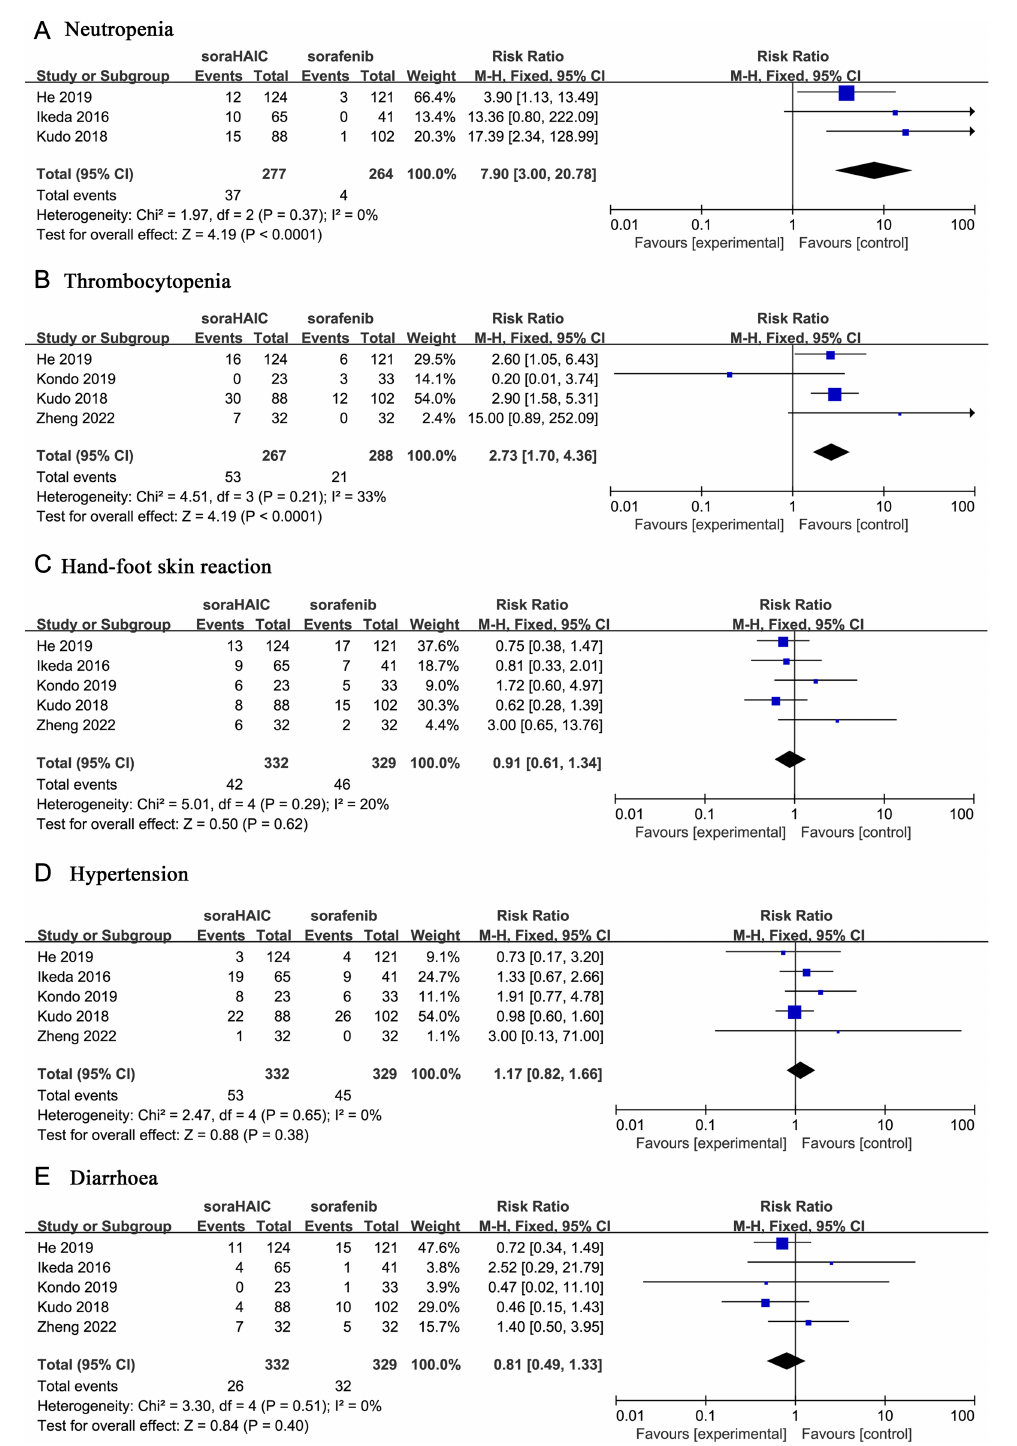
Figure 7. Forest plots comparing adverse effects between the SoraHAIC and sorafenib groups. (A) Neutropenia; (B) thrombocytopenia; (C) hand–foot syndrome; (D) hypertension; (E) diarrhea. SoraHAIC, sorafenib plus hepatic arterial infusion